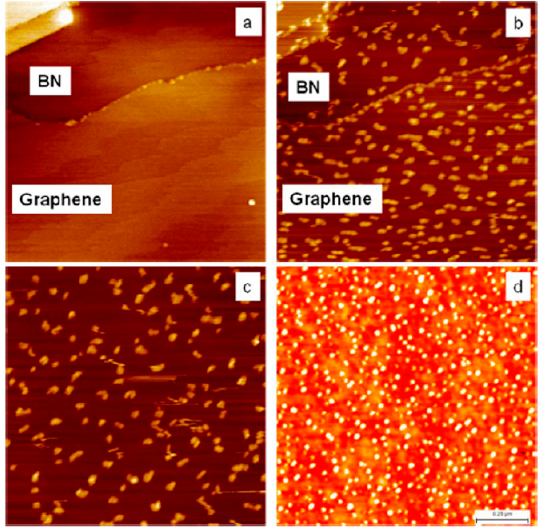
Figure 21. ( a ) Atomic Force Microscopy images (1 μ m × 1 μ m) of 1 layer graphene on hexagonal boron nitride (h-BN); and ( b ) Atomic Force Microscopy images (1 μ m × 1 μ m) of 0.1 nm Au deposited on 1 layer graphene supported on h-BN; ( c ) Atomic Force Microscopy images (1 μ m × 1 μ m) of 0.1 nm Au deposited directly on h-BN; ( d ) Atomic Force Microscopy images (1 μ m × 1 μ m) of 0.1 nm Au deposited on bilayer graphene supported on SiO 2 . Reproduced from Reference [60] with permission from the American Chemical Society.